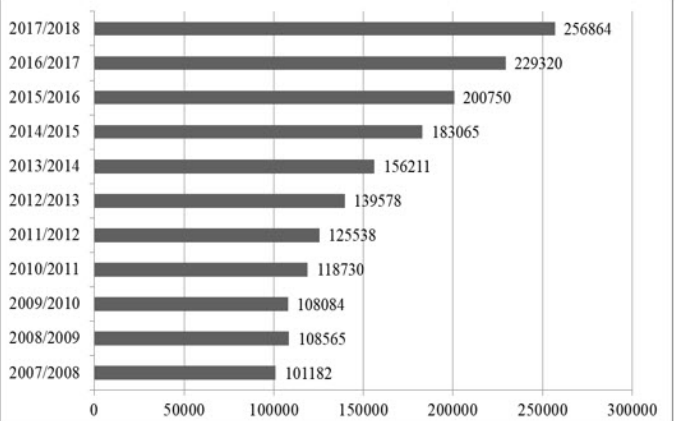
Figure 3. Foreign students enrolled in Russian universities (2007-2018), people